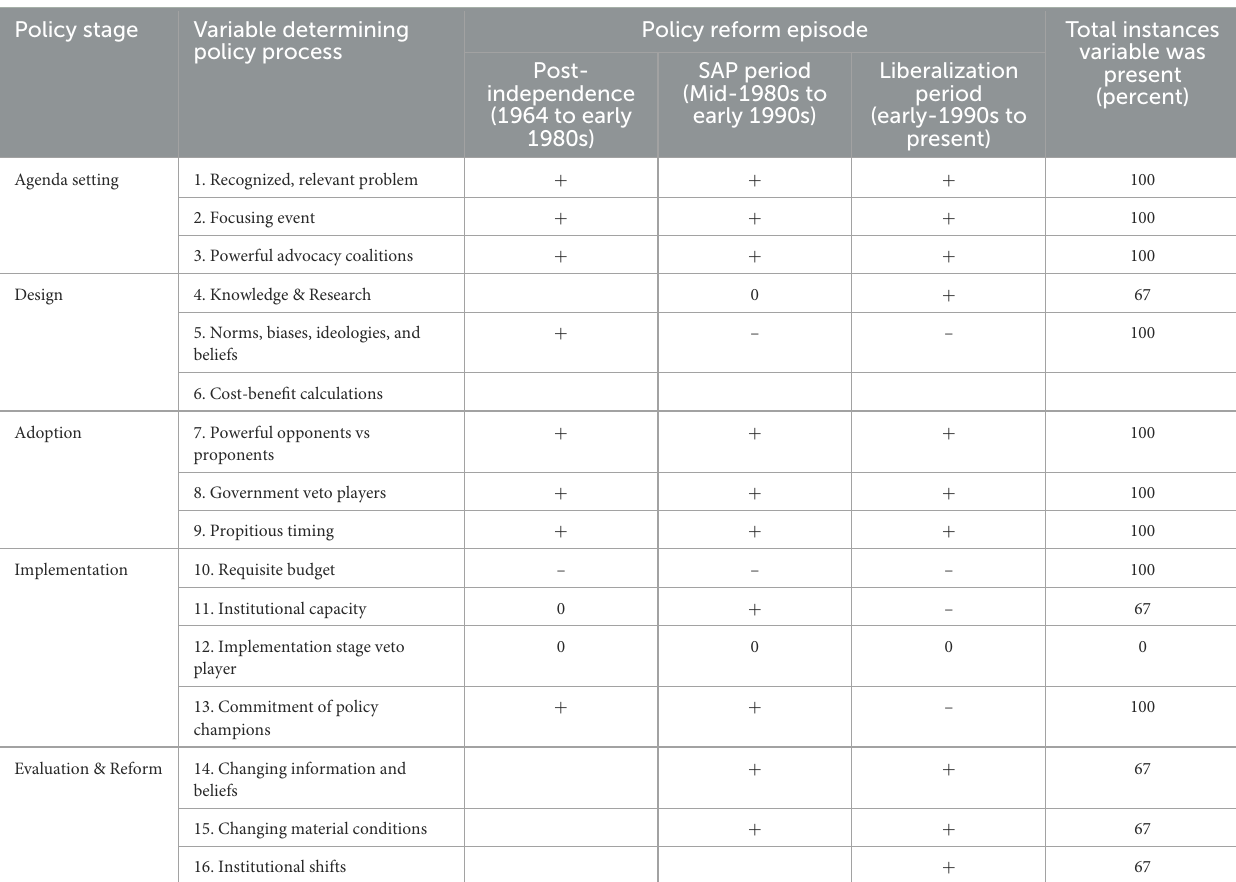
TABLE 1 Variables influencing the Malawi seed sector policy